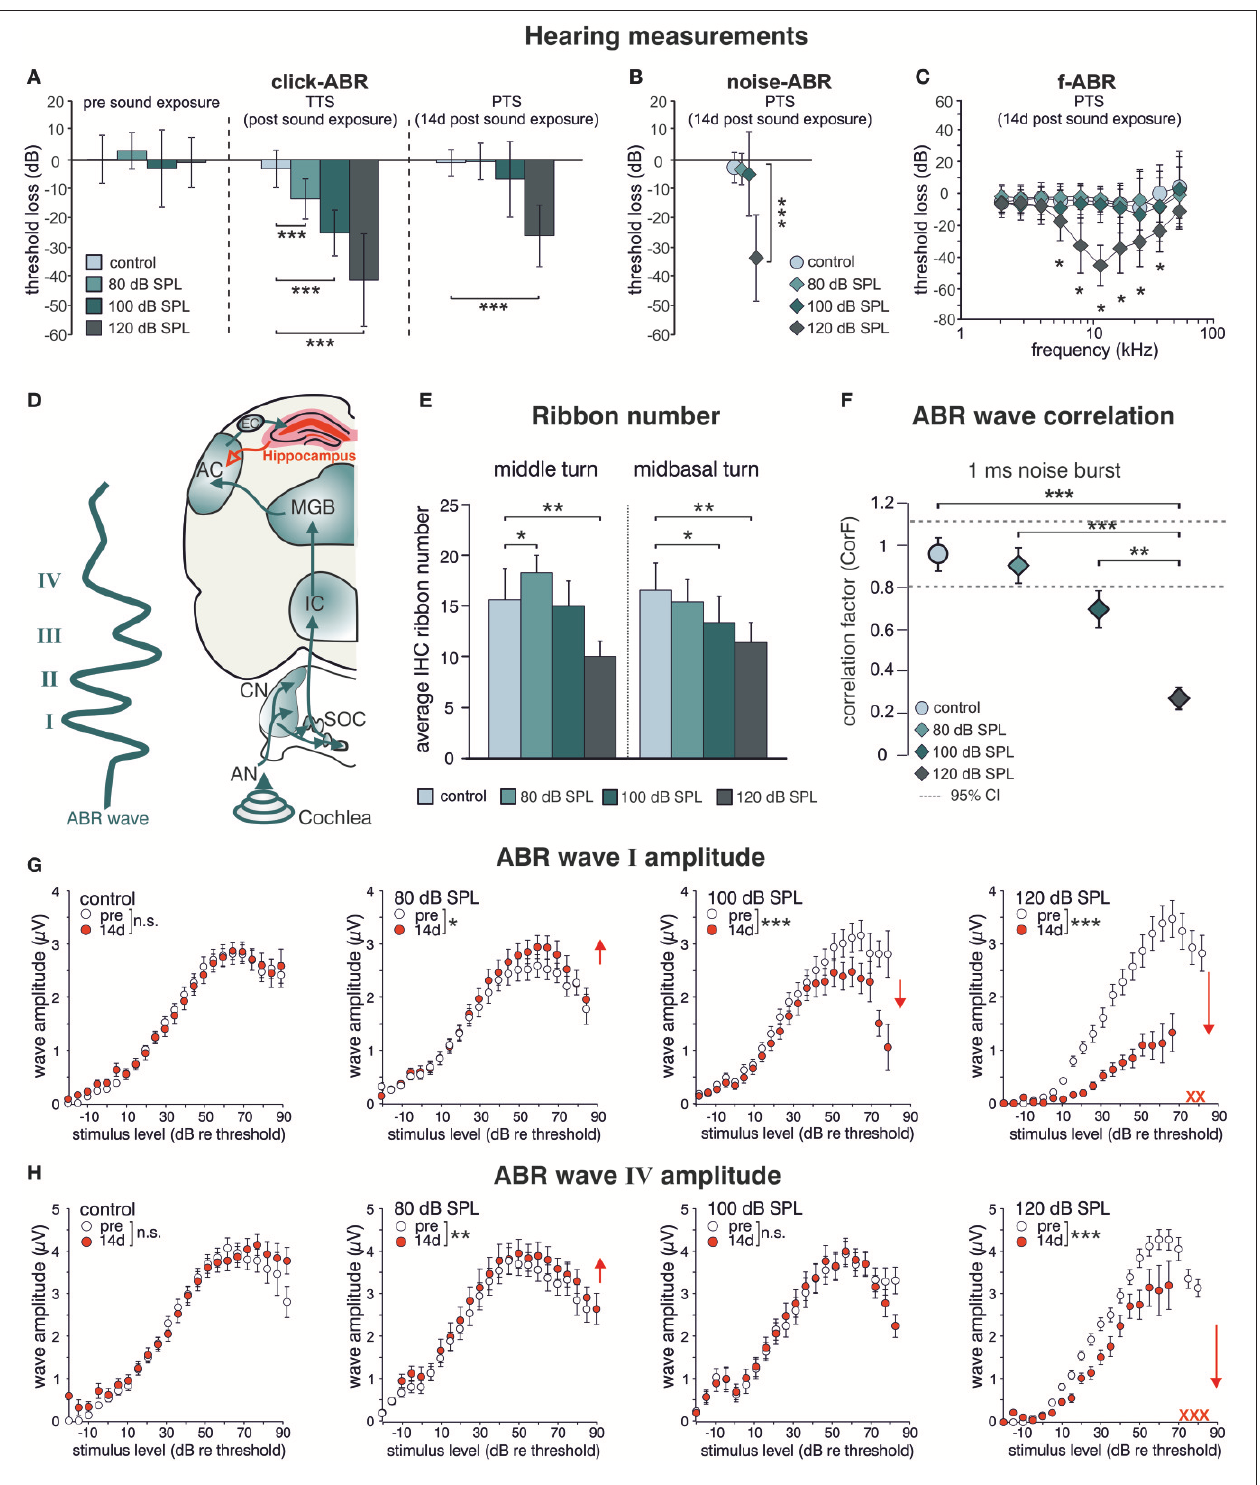
FIGURE 1 | Acoustic enrichment increases hearing acuity through central adaptation while acoustic trauma leads to uncompensated hearing loss. Homozygous BLEV reporter mice were sham exposed (control) or exposed to a 10kHz tone of 80, 100, or 120 dB SPL for 40min. Mean ABR thresholds ± SD for click stimuli ( A , click-ABR) before (pre sound exposure), directly after (TTS) and 14 d after sound exposure (PTS), for noise burst stimuli ( B , noise-ABR) and for frequency-specific stimuli ( C , f-ABR) 14 d after exposure demonstrate a significant temporary threshold shift (TTS) for all paradigms directly after exposure becoming permanent